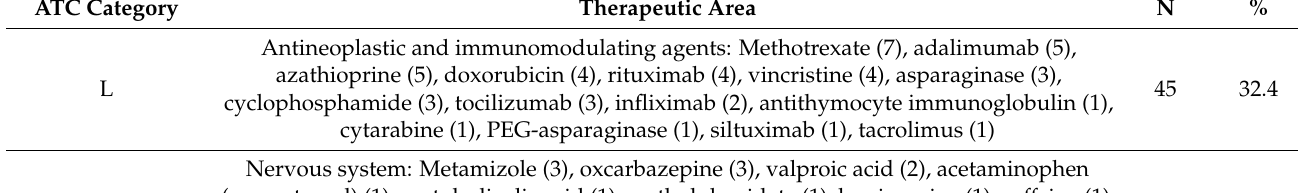
Table 2. Involved drugs classified according to the Anatomical Therapeutic Chemical (ATC) classification system. ATC Category Therapeutic Area N % Antineoplastic and immunomodulating agents: Methotrexate (7), adalimumab (5), azathioprine (5), doxorubicin (4), rituximab (4), vincristine (4), asparaginase (3), L cyclophosphamide (3), tocilizumab (3), infliximab (2), antithymocyte immunoglobulin (1), cytarabine (1), PEG-asparaginase (1), siltuximab (1), tacrolimus (1) Nervous system: Metamizole (3), oxcarbazepine (3), valproic acid (2), acetaminophen (paracetamol) (1), acetylsalicylic acid (1), methylphenidate (1), bupivacaine (1), caffeine N